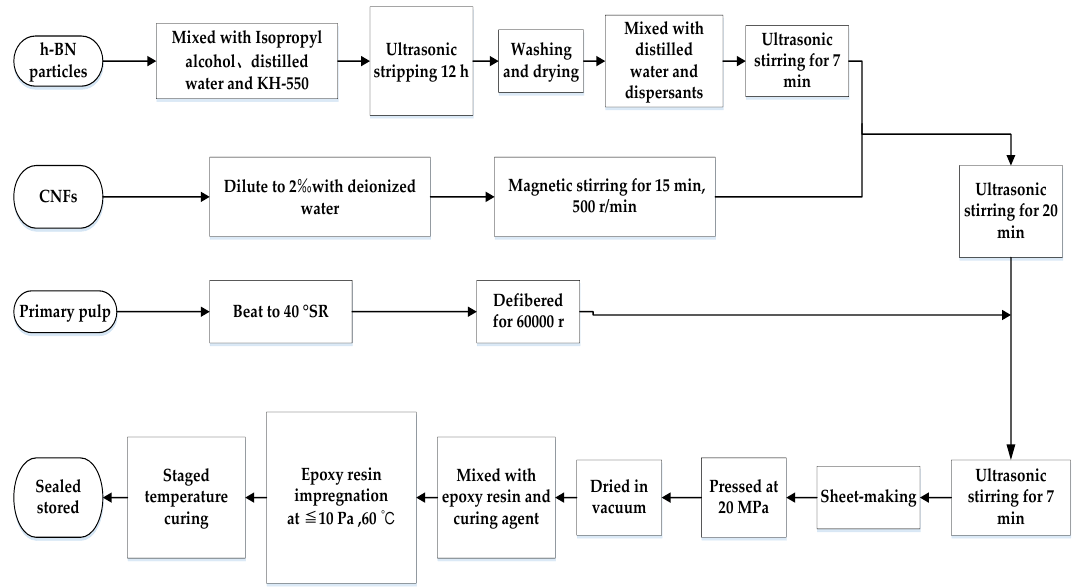
Figure 1. Flow chart of the process of creating epoxy resin-impregnated nano-hexagonal boron nitride (h-BN) + nano-cellulose fiber (CNF)-modified pressboard.